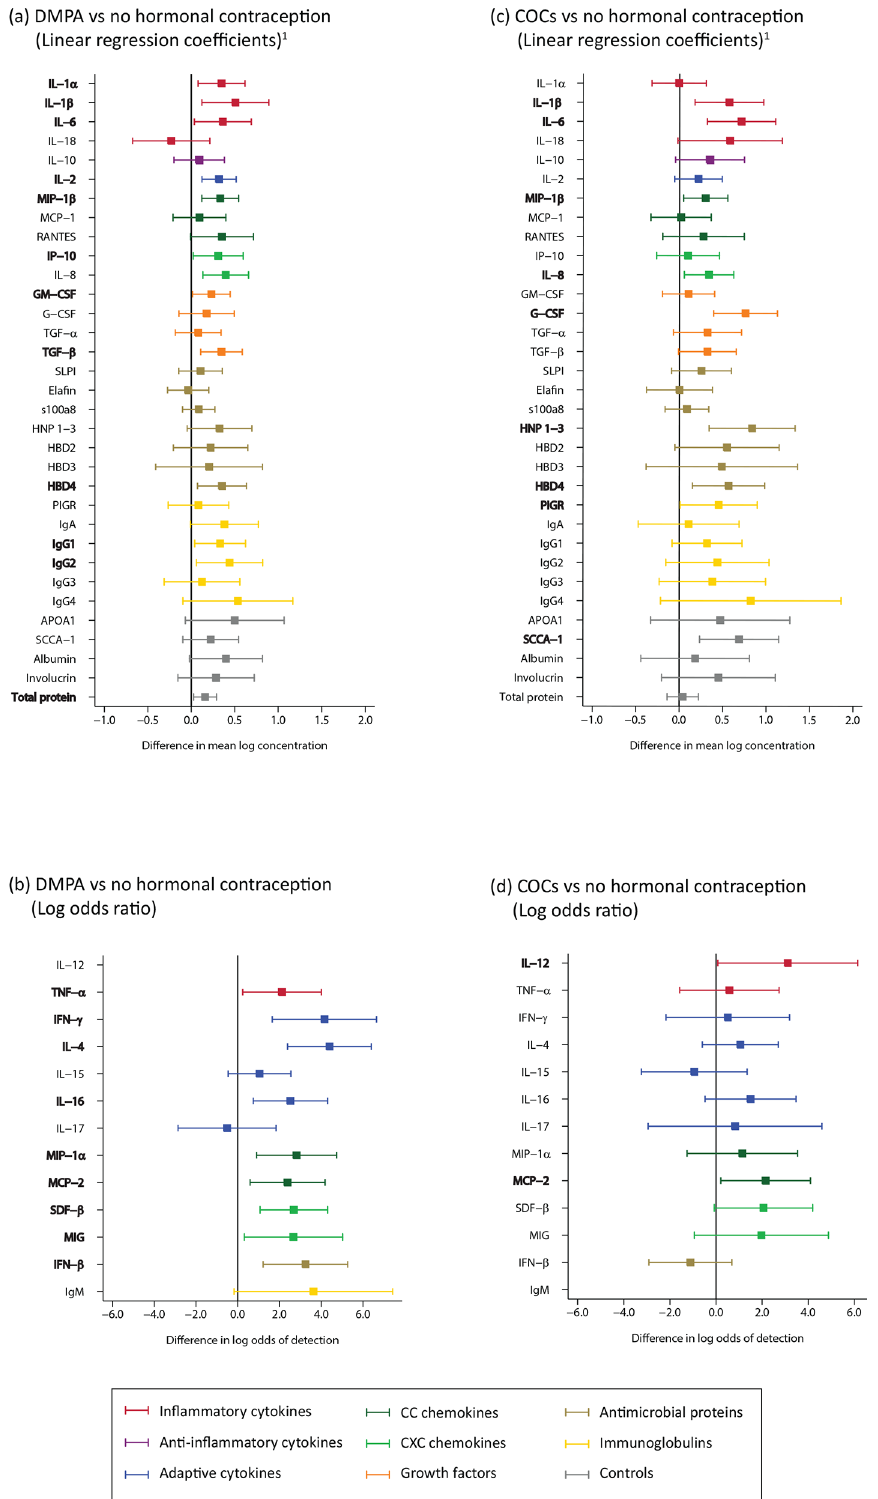
Fig 3. Reported hormonal contraceptive use (DMPA, n = 327; and COC, n = 305). Bolded analytes represent associations with a p-value (cid:1) 0.05. (A) A comparison of analyte concentration (cid:3) 85% between samples DMPA and women who reported no hormonal contraception use (reference) using linear